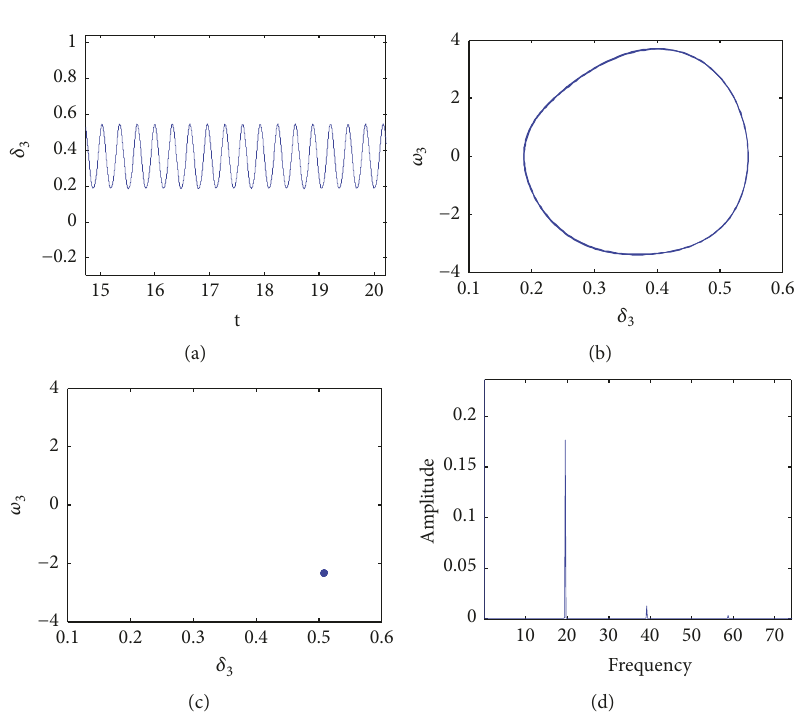
Figure 18: Period 1 motion ( 𝑉 𝐵1 = 0.5). (a) Time history. (b) Phase portrait. (c) Poincar´e map. (d) Frequency